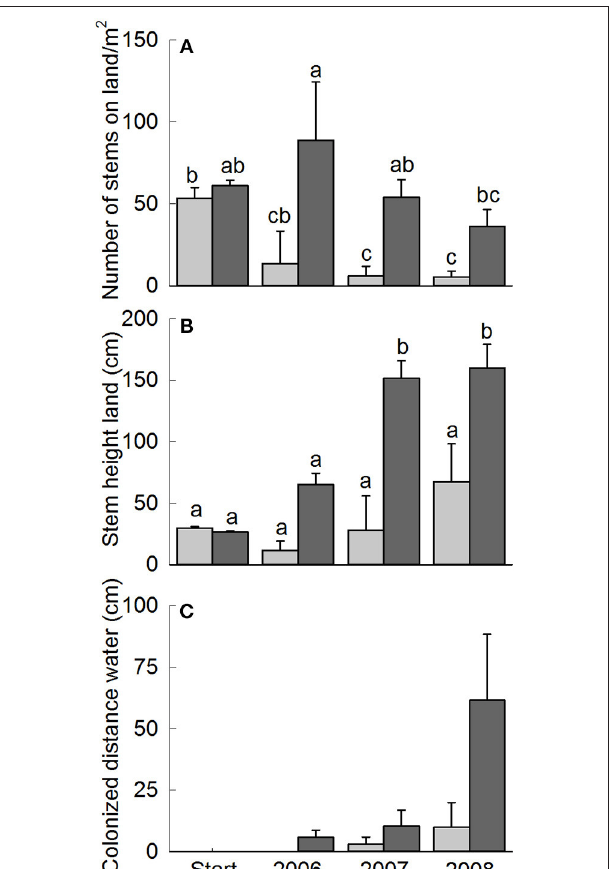
FIGURE 5 | Reed density (A) , stem height of reed on land (B) and distance colonized by reed stems away from the bank into the open water (C) of planted reed in Lake Terra Nova. Start refers to the planting of the reed plants in June 2006, following measurements were done late August-early September. Data are means ± SE, n = 5. Different letters indicate significant differences among the control and exclosure treatments and years at P <